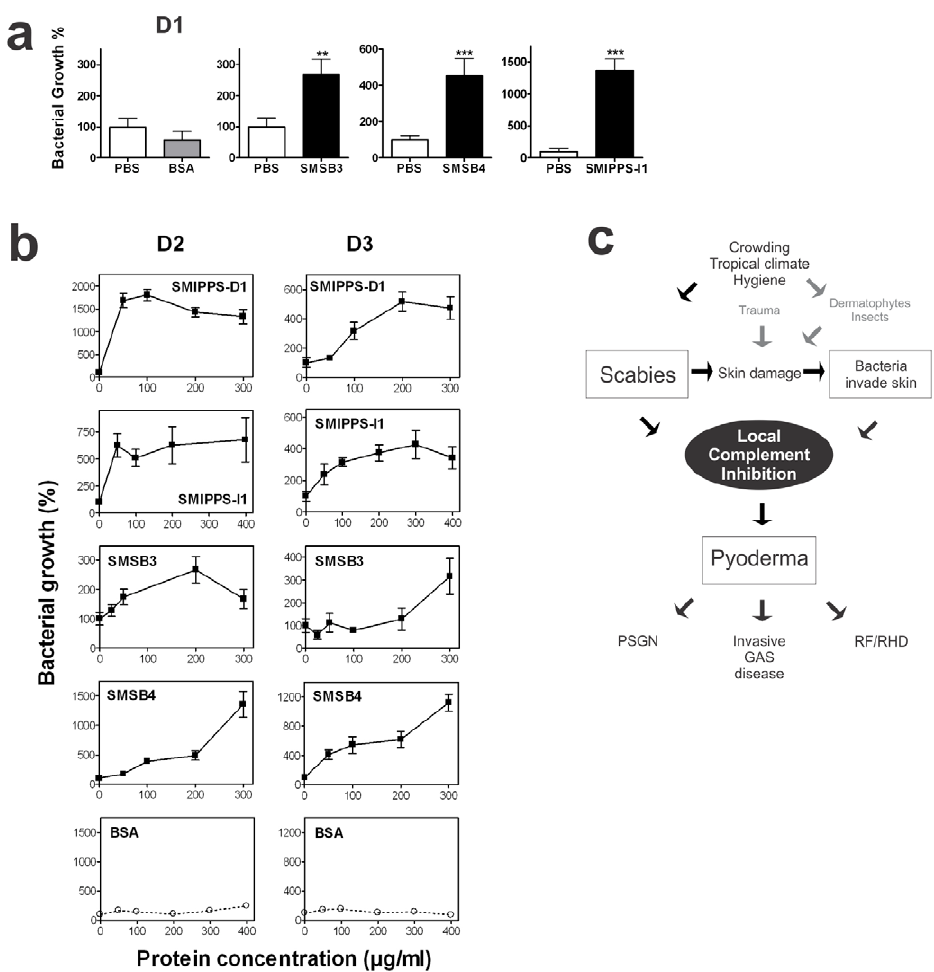
Figure 3. Scabies mite complement inhibitors enhance group A streptococcal growth in human whole blood. ( a ) Increased GAS growth in whole blood from a human donor with a type-specific immune response to the GAS strain investigated (D1) in presence of SMSB4 [25 m g/ml], SMSB3, SMIPP-S I1 or BSA [200 m g/ml]. Shown are means 6 SEM (n=4 experiments). ( b ) Means 6 SEM of n=6 to 12 standardized assays with whole blood from two donors who did not exhibit type-specific immunity to the GAS strain used in this study. (D2, D3) supplemented with heat-inactivated antibody serum from D1. (c) Novel model on potential scabies, bacteria and host interactions. **p , 0.01, ***p , 0.001 by t test (GraphPad Prism). S. pyogenes strain 2967emm1 was isolated from human